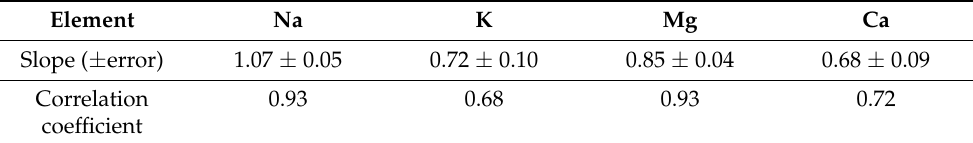
Table 3. Slopes ( ± error) and Pearson’s correlation coefficients for the four elements analyzed by both techniques, namely sodium, potassium, magnesium and calcium. Correlations are all significant ( p < 0.01, n = 58).